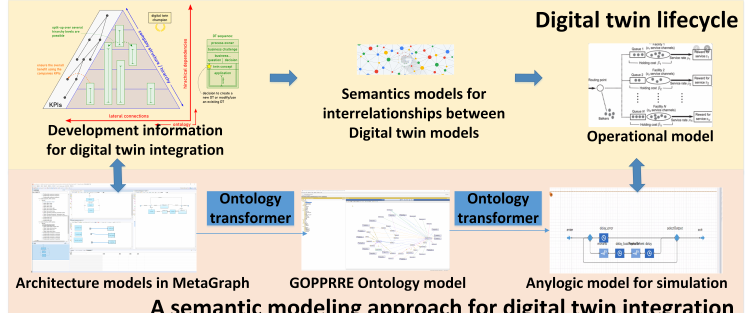
Figure 6. Ontology models for digital twins integration.